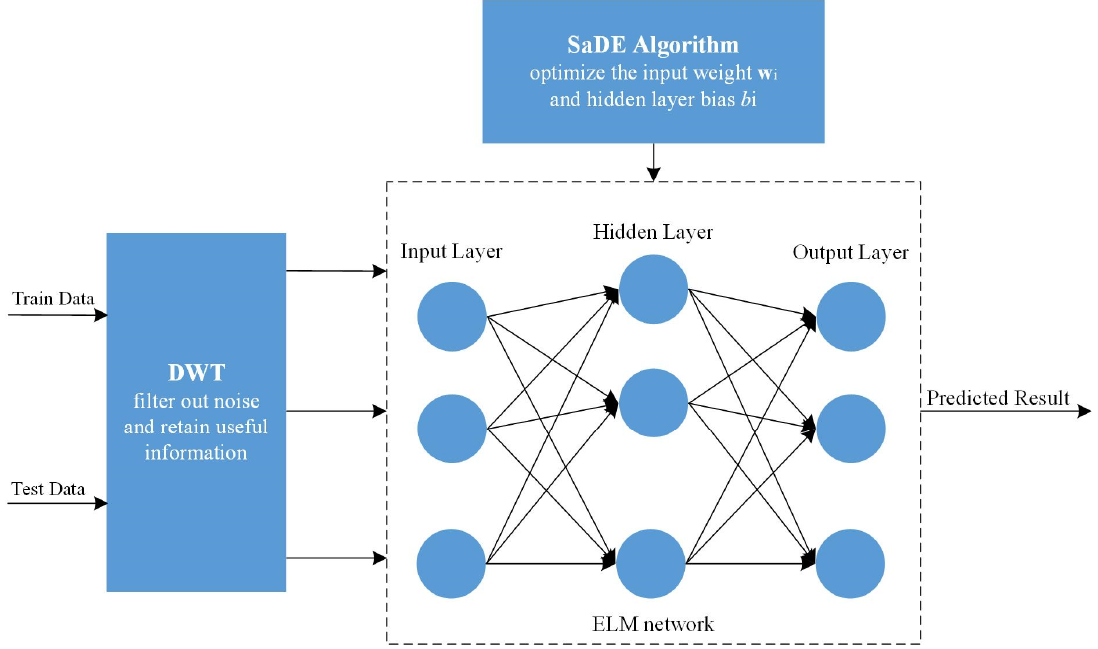
Figure 5. Remaining useful life (RUL) prediction framework based on D-S ELM.